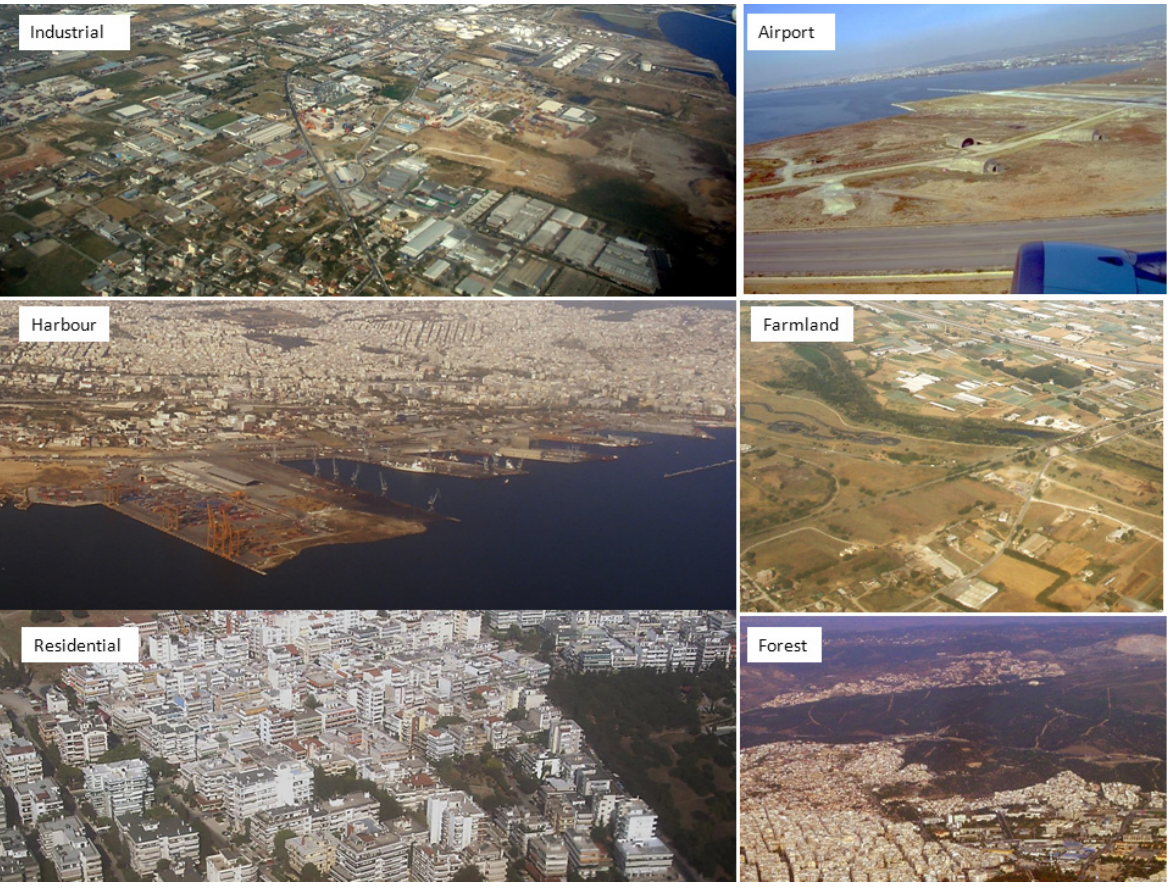
Figure 1. Main land use types in the Thessaloniki